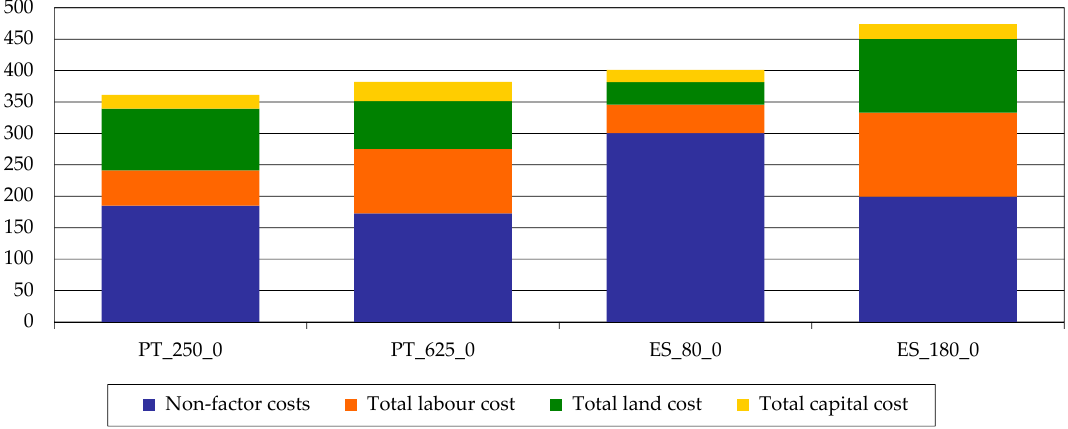
Figure 9. Cost by factor and non-factor costs ( € / 100 kg LW). Source: model results.